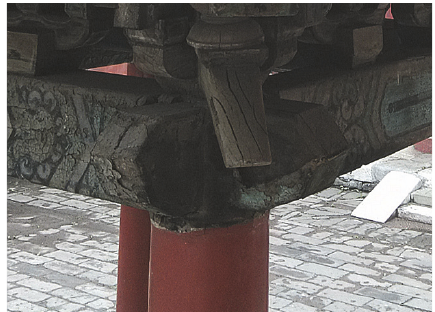
Figure 11: Beam-column connection at the column